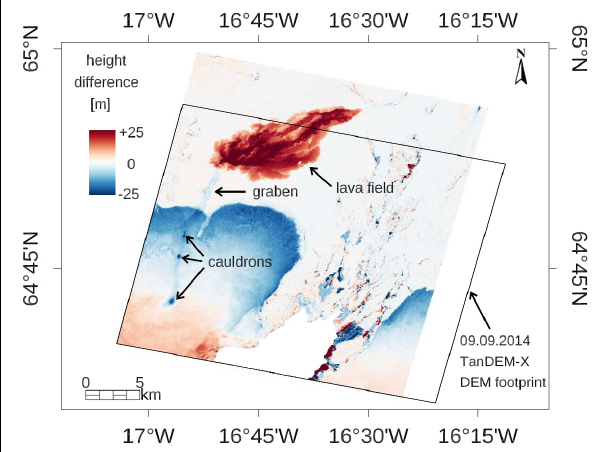
FIGURE 8 | Topographical changes North Vatnajökull and Holuhraun area during the unrest and eruption. TanDEM-X DEMs generated using bistatic acquisitions prior, during and after the eruption allowed to detect height variations on the glacier, with the formation of new cauldrons, inland, with the newly formed lava field, and on both with the dyke-induced graben. The black rectangle shows the first TanDEM-X DEM that was made available to the Science group in the fall 2014 as presented in Rossi et al. (2012). Modified from Dirscherl and Rossi (2018) with permission of